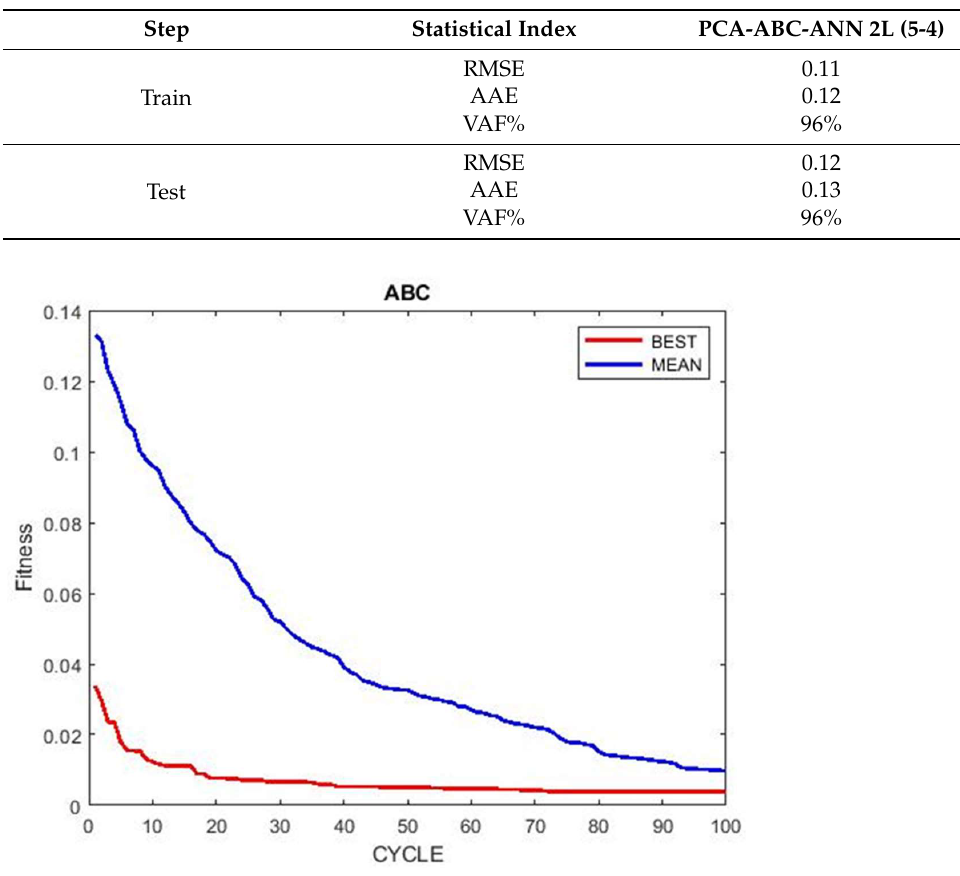
Figure 7. Topology of a feed-forward model with two hidden layers (4-5-4-1 topology). Table 8. Statistics of the best ANNs combined with the ABC algorithm using the 4-5-4-1 topology.